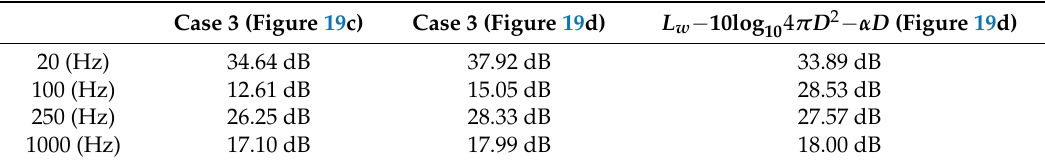
Table 1. Comparisons of SPL at some selected